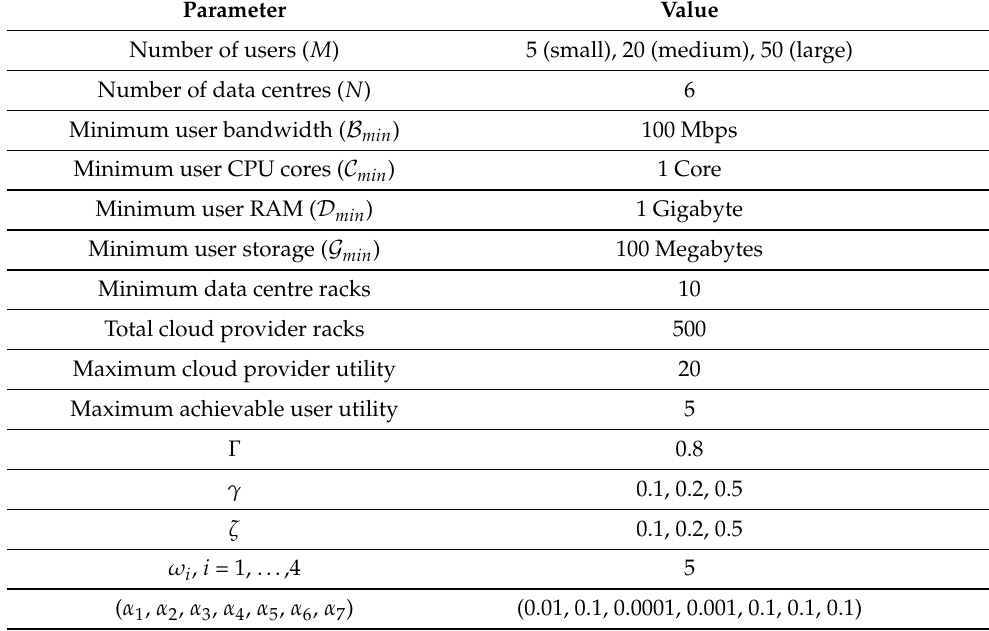
Table 3. Simulation